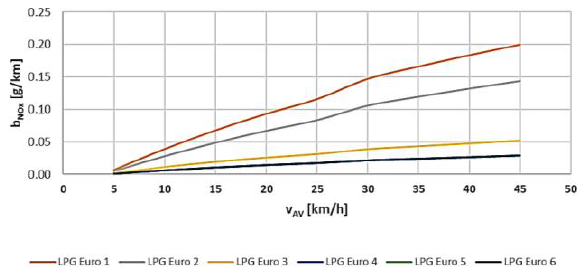
Fig. 13. NO x emission from LPG PCs for Euro standards depending on average speed